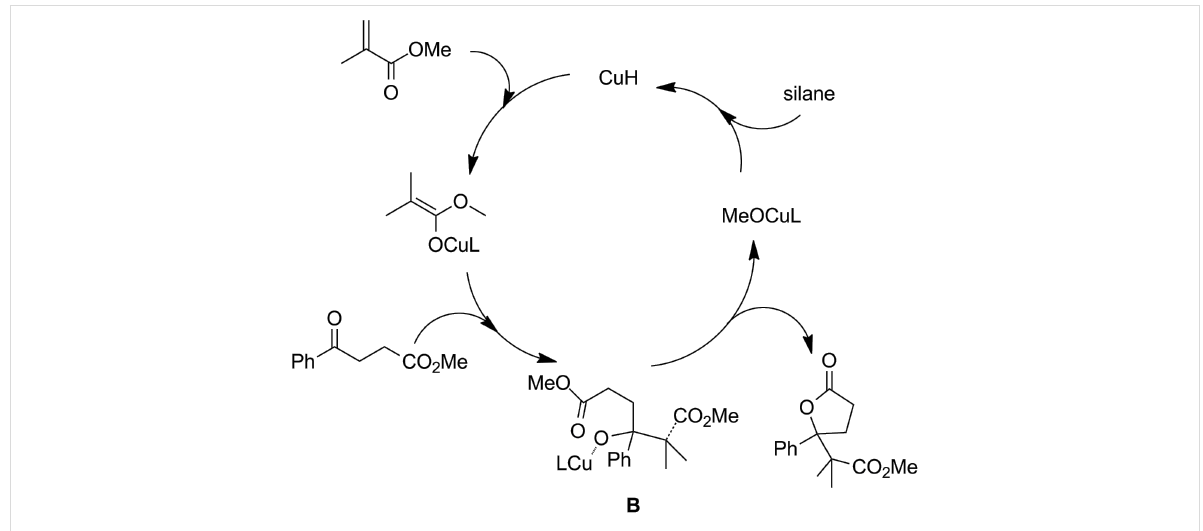
Figure 2: Possible copper-catalyzed reductive aldol–lactonization reaction of acrylate with a keto ester and silane.